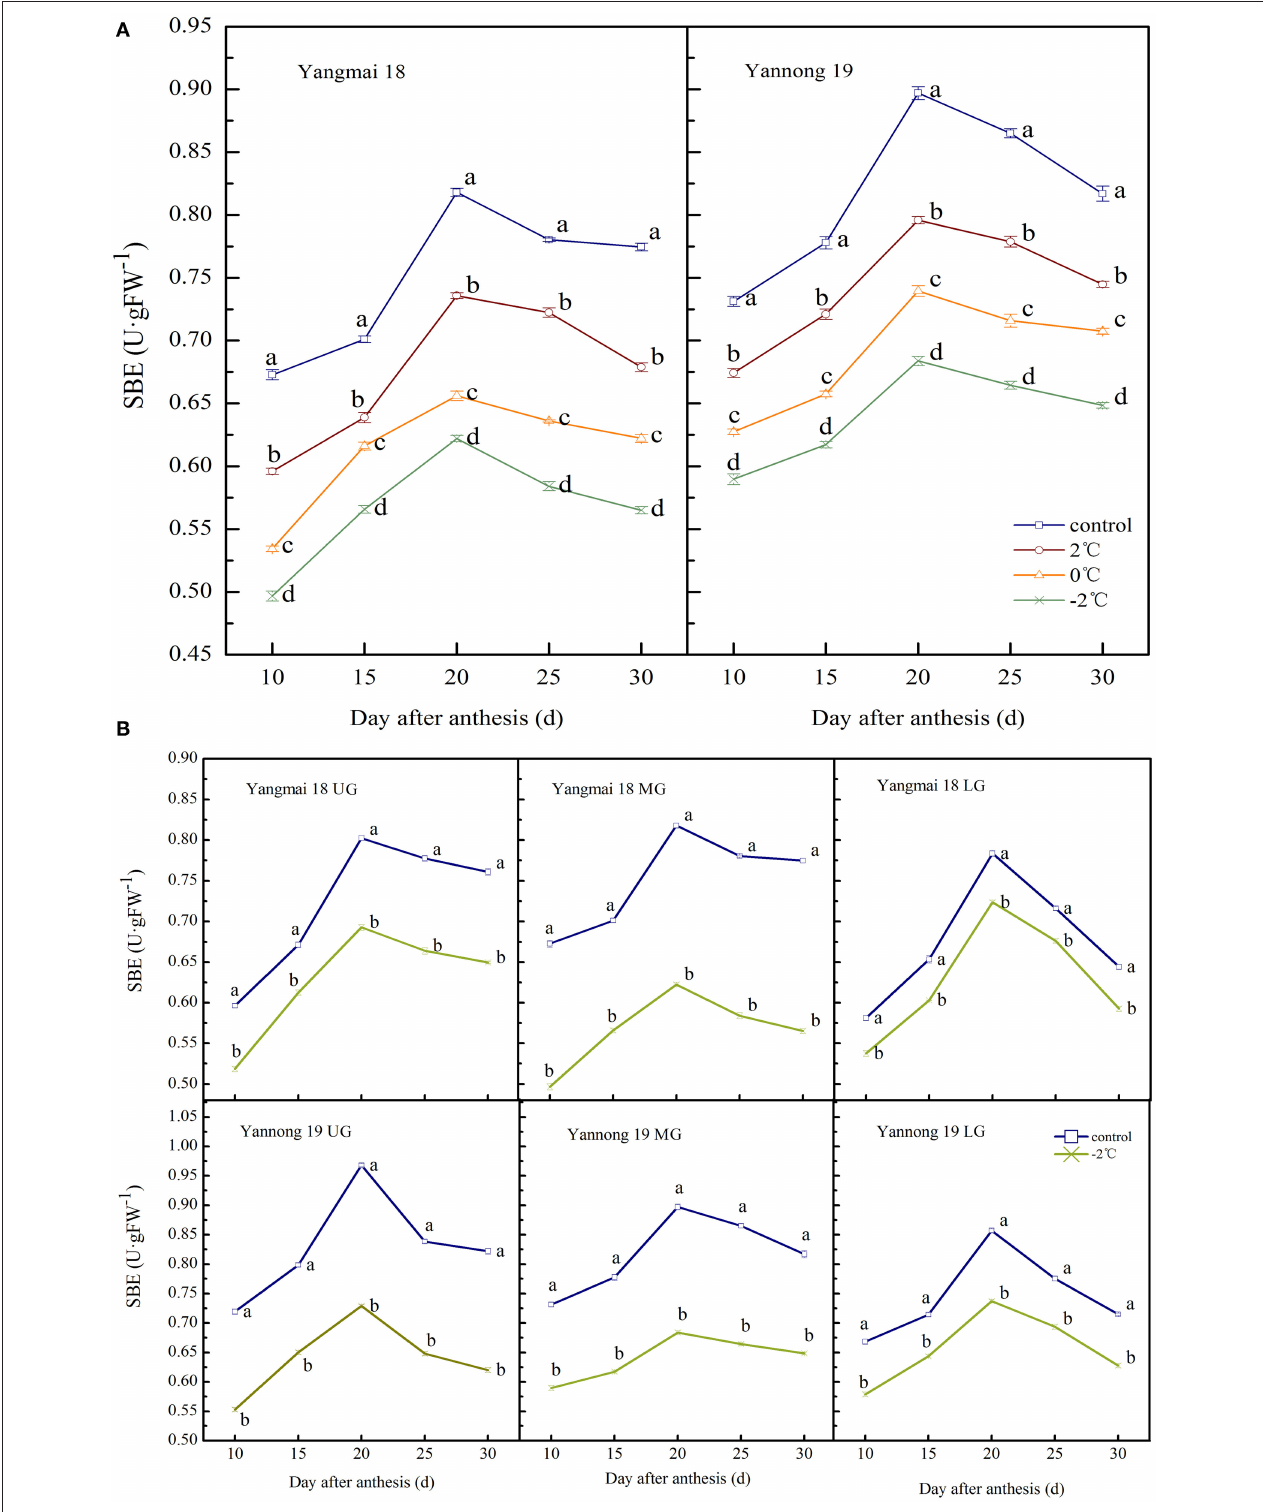
FIGURE 6 | The effect of short-term LT at the booting stage on the starch branching enzyme activity of wheat grains in the middle spikelets (A) and at different position spikelets (B) . UG, grains in the upper spikelets; MG, grains in the middle spikelets; LG, grains in the lower spikelets. At the booting stage, wheat plants